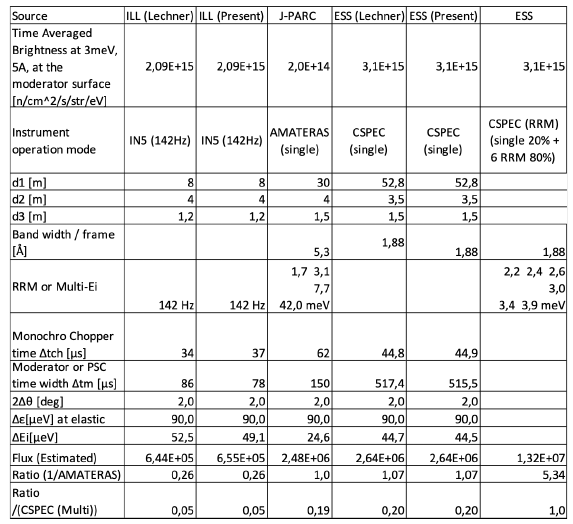
Table 1 . Parameters and performance in comparison with Lechner's concept [1], where the time averaged brightnesses for 1MW of J-PARC, 5MW of ESS and 57MW of ILL are taken as shown in Fig. 1.